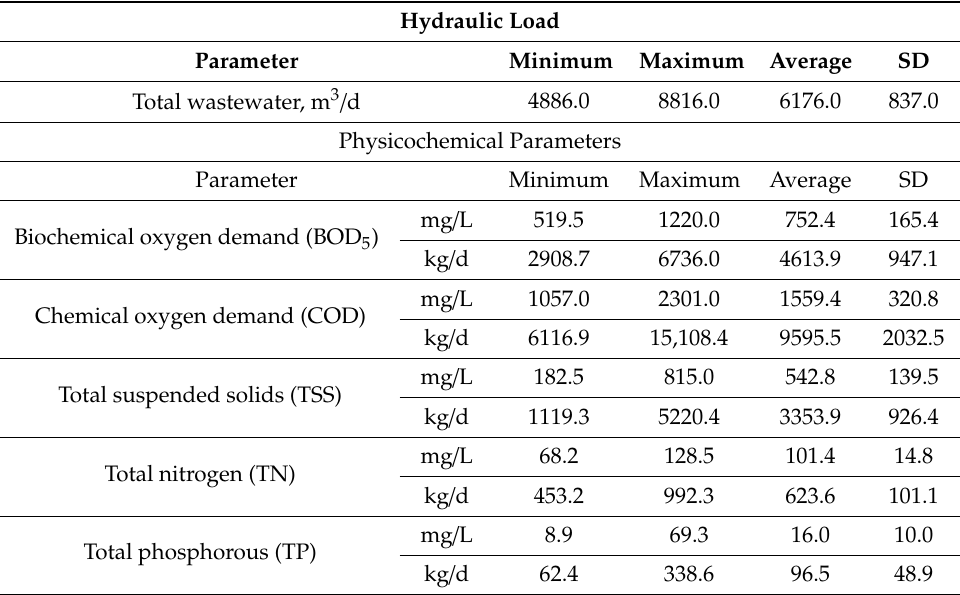
Table 3. Characteristic of the influent wastewater in 2017–2019.